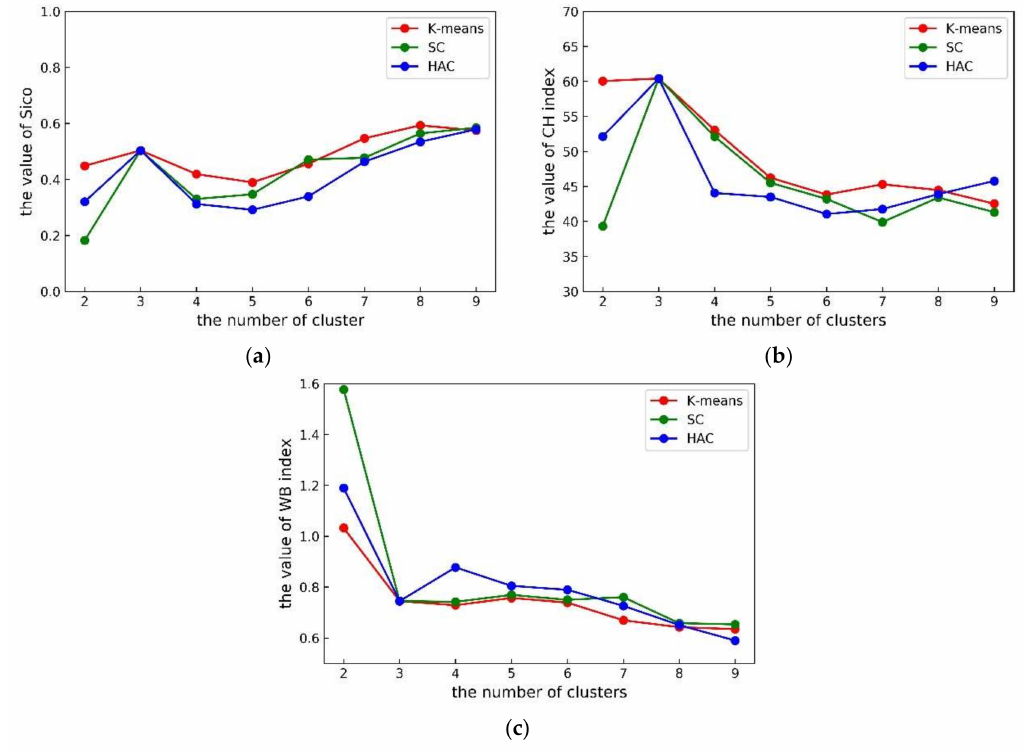
Figure 3. The variation of indices with the increase of cluster number for the different models: ( a ) Silhouette coefficient; ( b ) Calinski-Harabaz index; ( c ) WB